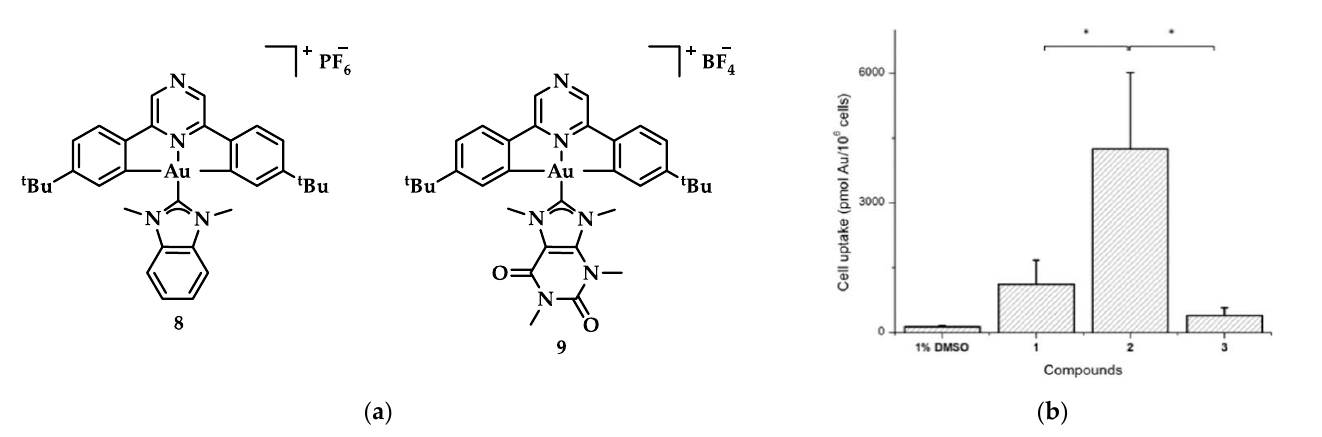
Figure 16. ( a ) Chemical structures of [(C^N pz ^C)AuL] + type complexes; ( b ) Cellular uptake graph where 2 corresponds to 8 and 3 to 9 . * p < 0.05. Adapted with permission from Ref. [143] . Copyright (2017) American Chemical Society.